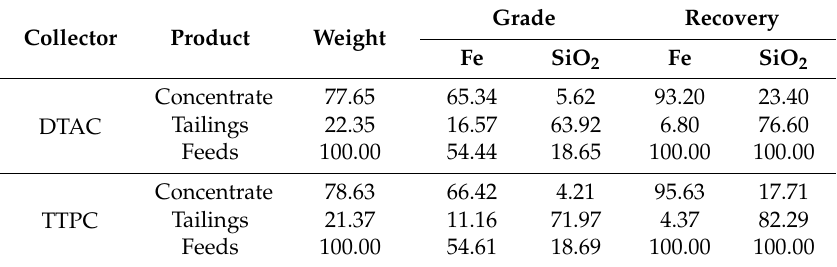
Table 5. Reverse cationic flotation results of iron ore with TTPC and DTAC as collectors at a natural pH (6.5–7.0) (wt %).